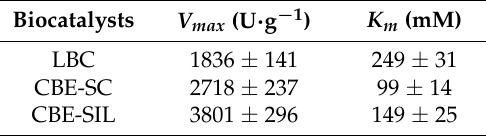
Table 1. The Michaelis constant ( K m ) and the maximum reaction velocity ( V max ) of the free enzyme determined by measuring initial rates of the reaction. Where free lipase from Burkholderia cepacia (LBC), immobilized by covalent binding without ionic liquid (CBE-SC) and immobilized with ionic liquid (CBE–SIL), are compared.